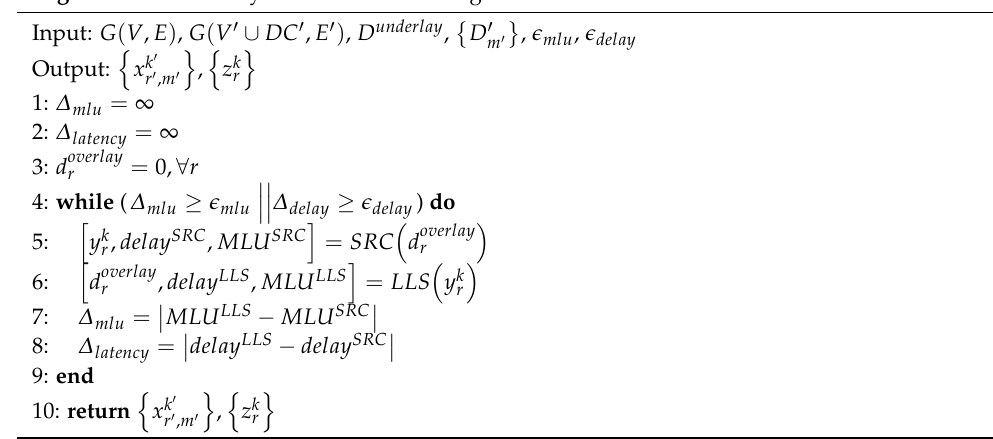
Algorithm 1 Cross-Layer Model Iterative